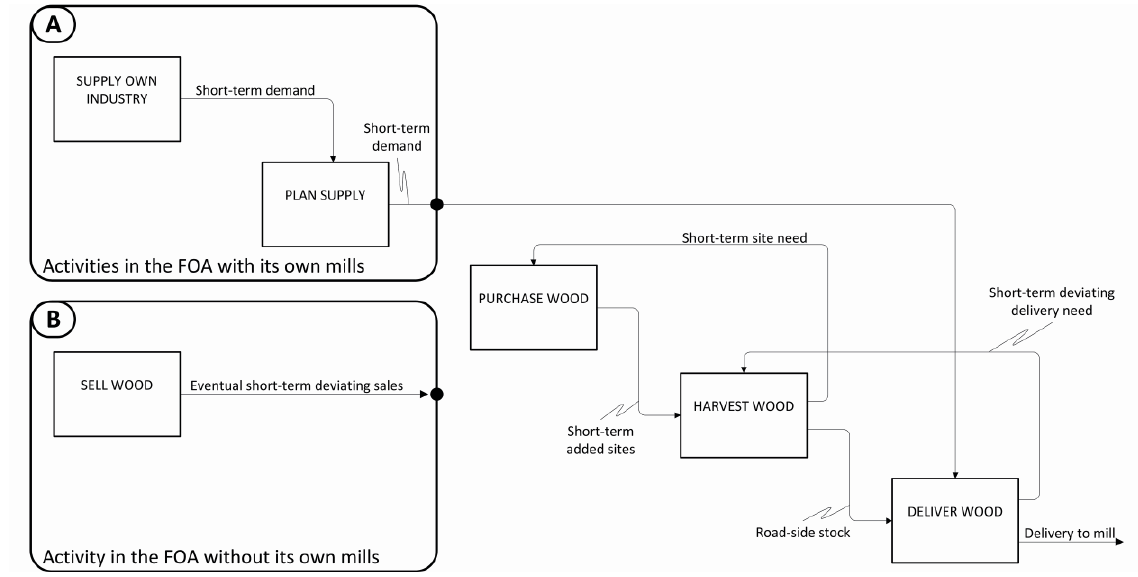
Figure 7. Information flows in operational activities within the functions of the forest owners associations (FOAs). Inset A marks activities in the FOA with its own mills. Inset B marks the corresponding activity in the FOA without its own mills. The three right-hand activities (unmarked) were common for both